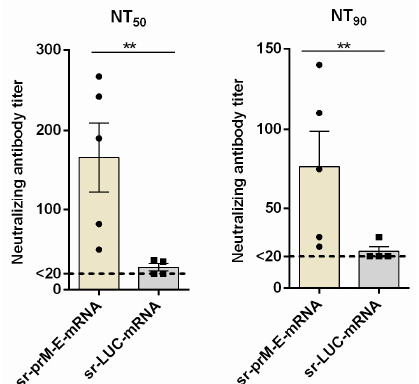
Figure 5. Zika virus neutralizing antibody titers after vaccination of IFNAR1 -/- mice with the sr-prM-E mRNA vaccine. Mice were intradermally electroporated on day 0 and 14 with 1 µg of sr-prM-E-mRNA ZIKV vaccine or sr-LUC-mRNA and two weeks after the boost, ZIKV-specific neutralizing antibody titers were determined by a neutralization test (NT). The neutralizing antibody titers are expressed as the reciprocal of the endpoint serum dilution that neutralized the challenge virus by ( a ) 50% (NT 50 ) or ( b ) 90% (NT 90 ). The lower limit of NT quantification was 20 and is represented by the dashed line ( n = 5 sr-prM-E-mRNA group and n = 4 sr-LUC-mRNA group).